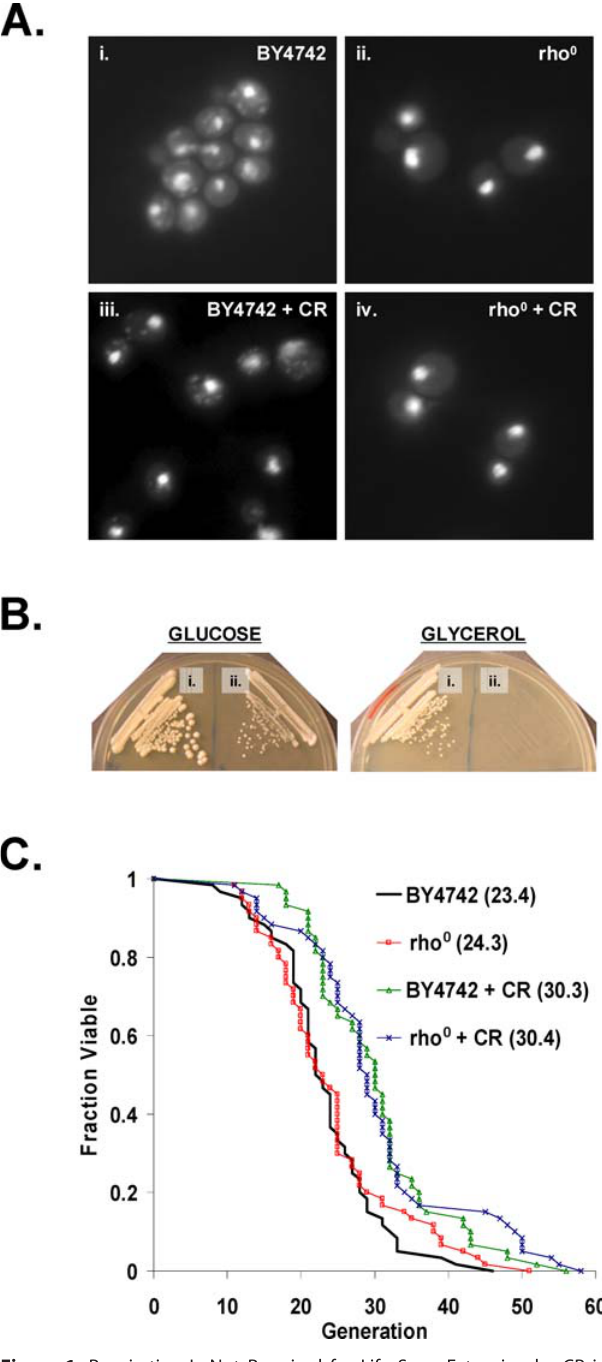
Figure 1. Respiration Is Not Required for Life Span Extension by CR in BY4742 (A) BY4742 rho 0 strains lack mitochondrial DNA. DAPI staining of BY4742 (i) wild-type or (ii) rho 0 cells grown under standard conditions (2% glucose) and calorie-restricted (iii) wild-type or (iv) rho 0 cells (CR ¼ 0.05% glucose). (B) BY4742 rho 0 strains are unable to grow on glycerol as the sole carbon source. (i) BY4742 wild-type or (ii) rho 0 cells on YEP supplemented with 2% glucose or 3% glycerol. (C) CR increase life span in BY4742 rho 0 cells. Replicative life span analysis for BY4742 wild-type and rho 0 cells on 2% glucose and 0.05% glucose (CR). Mean life span is shown in